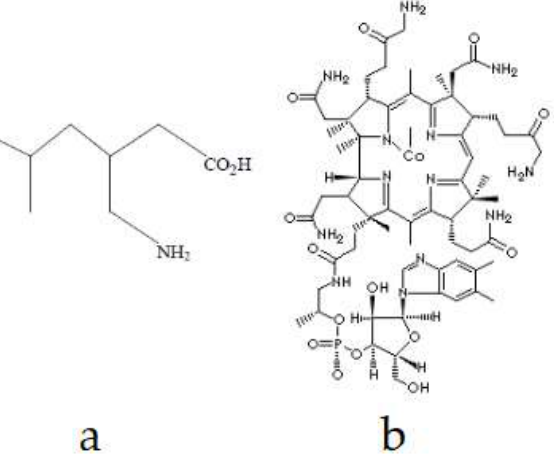
Figure 1. Chemical structure of PG ( a ) and MC ( b )